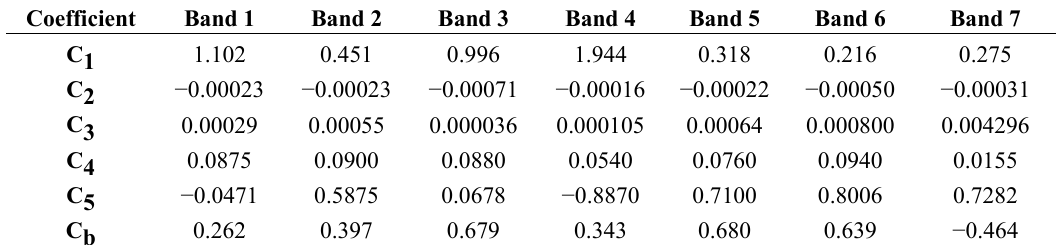
Table 1. Calibrated MODIS constants C defined in Equation (4). From Tasumi et al.